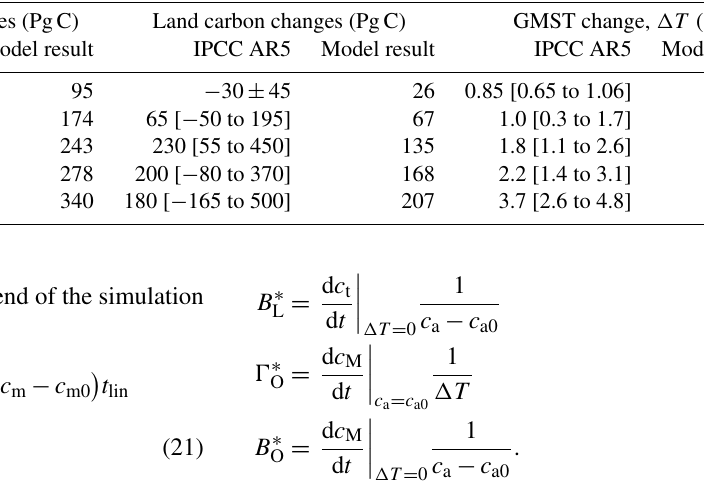
Table 2. Model validation. Historical changes are carbon stocks in 2011 relative to stocks in 1750 (Ciais et al., 2013) and temperatures in 2012 relative to temperatures in 1880 (Hartmann et al., 2013). Predicted future changes are carbon stocks in 2100 compared to 2012 (Collins et al., 2013) and global mean surface temperature (GMST) averaged over 2081–2100 relative to 1986–2005 (Collins et al., 2013), under the range of RCP